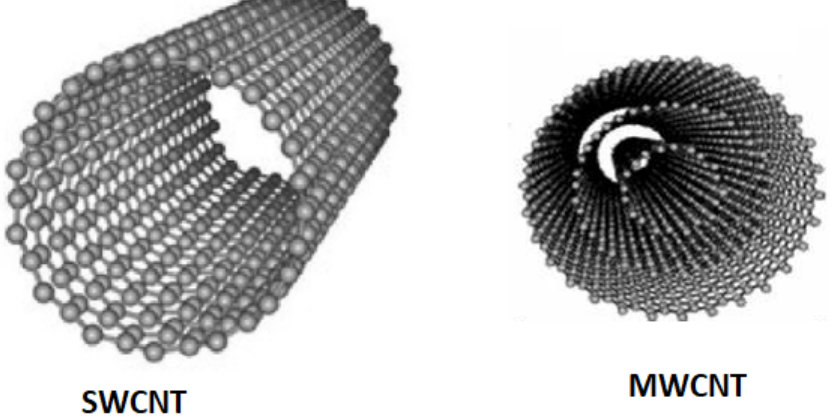
Figure 6. Structure of CNT (SWCNT and MWCNT) carbon-based nanomaterials.